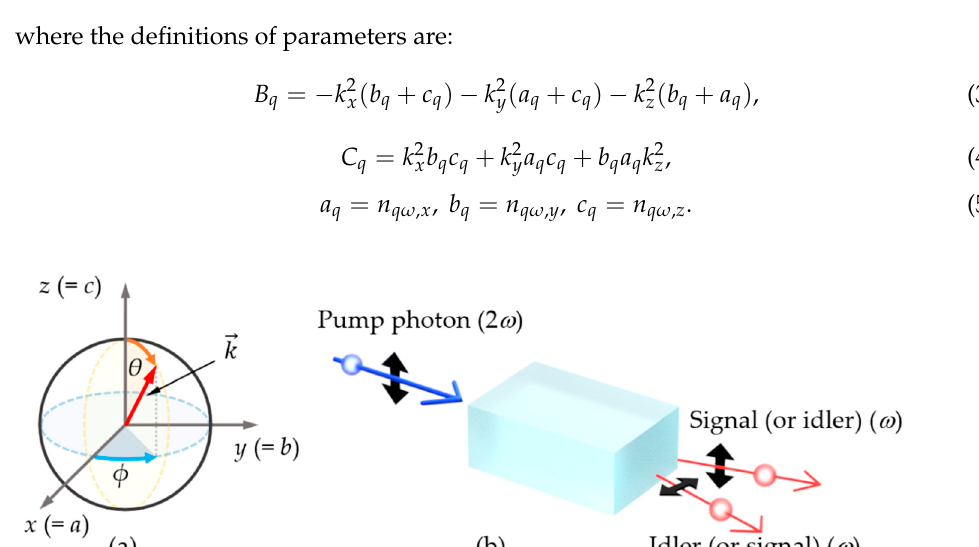
Figure 1. ( a ) A schematic diagram showing the definition of the crystallographic and optical axes of potassium titanyl phosphate (KTP) isomorphs in the spherical coordinate, where the wave vector, k represents the direction of beam propagation. ϕ and θ are the azimuthal and polar angles, respectively. ( b ) Type II spontaneous parametric down-conversion (SPDC): an input single photon (pump) with a frequency of 2 ω generates a pair of photons (signal and idler) with the same frequency of ω that are orthogonally polarized to each